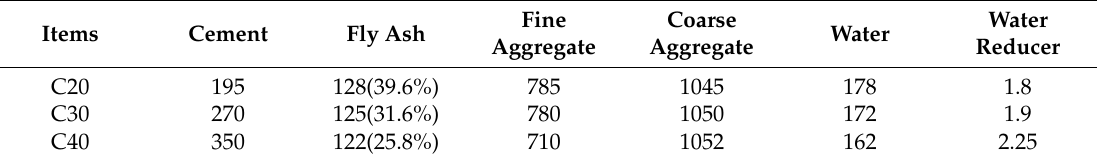
Table 3. Mix of concrete (kg/m 3